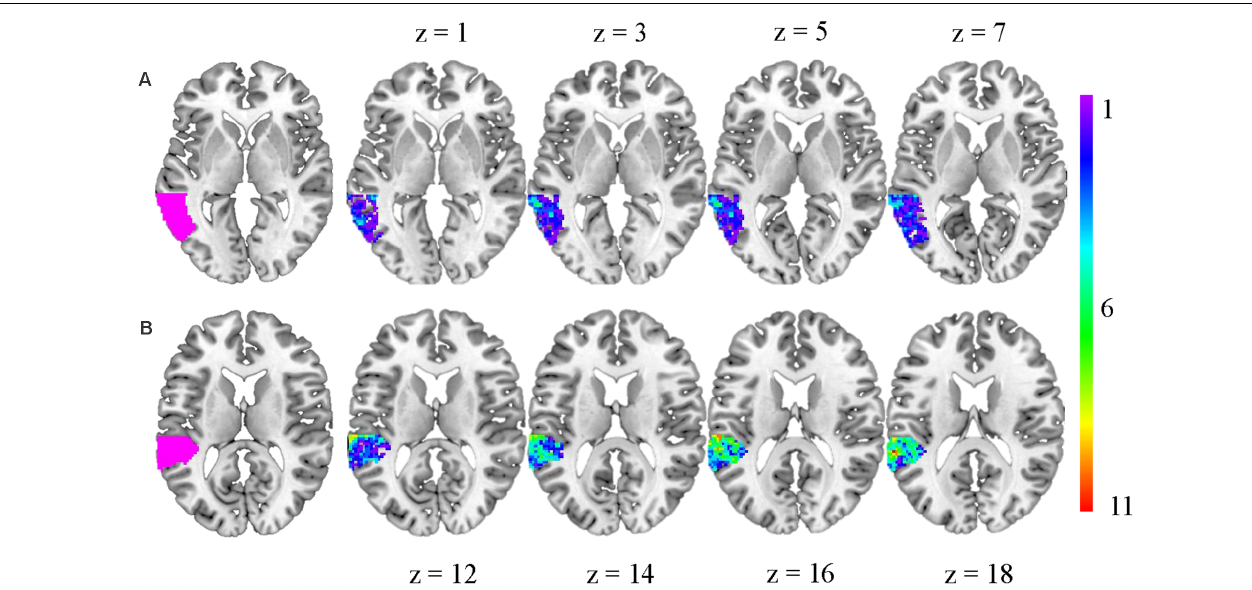
FIGURE 1 | Schematic depiction of the two regions-of-interest (ROIs): (A) posterior middle temporal gyrus (pMTG); and (B) posterior superior temporal gyrus (pSTG). The first slice in each row represents the anatomical mask within which each participant’s ROI was selected. The color gradient displayed within the other slices represents the spatial overlap among the ROIs across participants. Each color represents the number of participants for which a particular voxel was included within an ROI (see the scale to right).